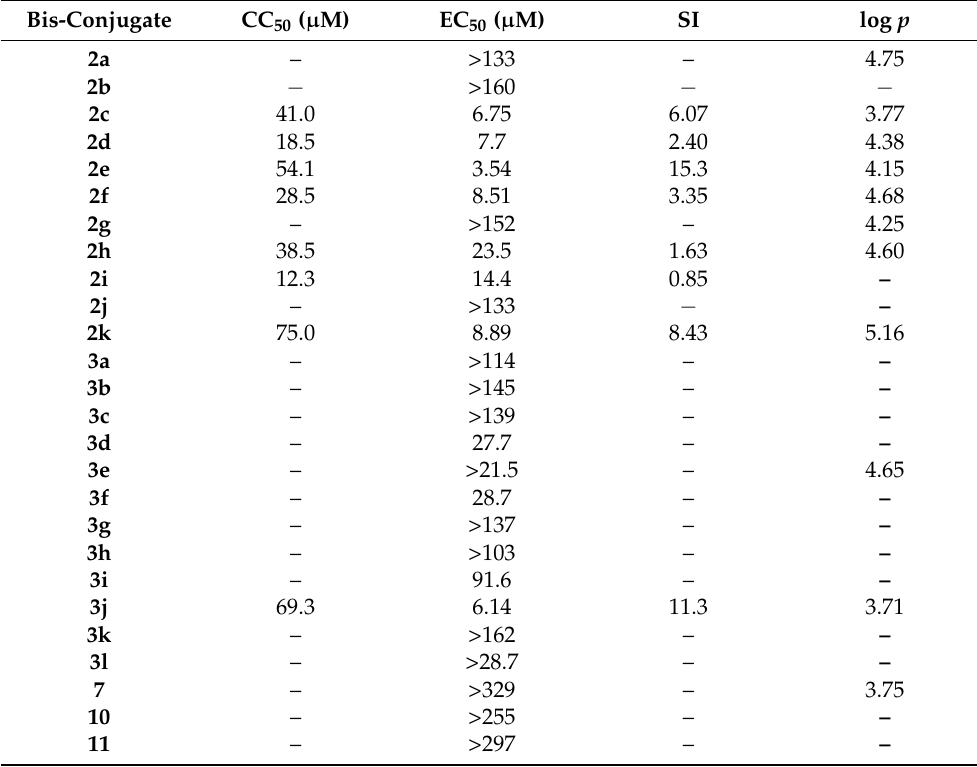
Table 1. Biological activity of conjugated compounds and their lipophilicity.